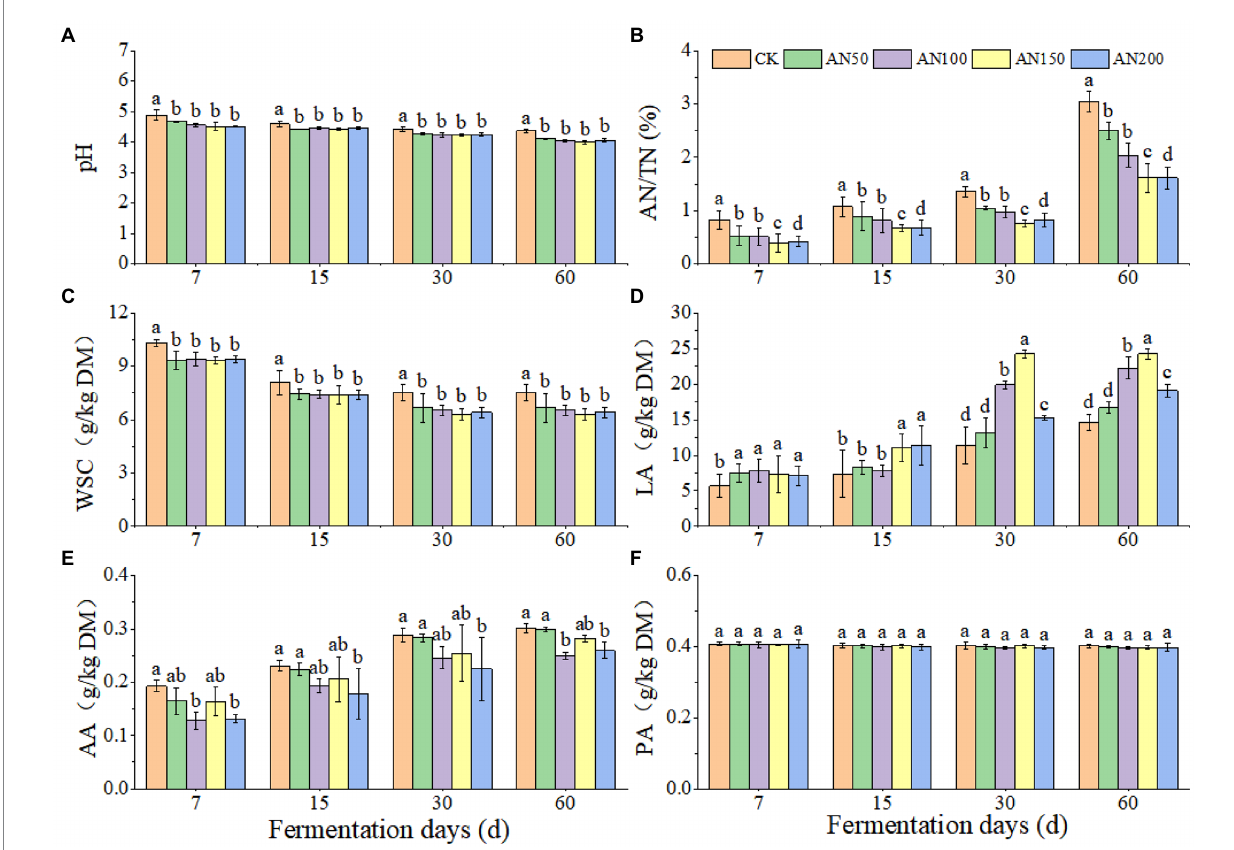
FIGURE 5 Silage quality of ratooning sorghum ensiled with different concentrations of A. niger . (A) , pH; (B) , ammonia nitrogen (AN); (C) , water soluble carbohydrate (WSC); (D) , lactic acid (LA); (E) , acetic acids (AA); (F) , propionic acid (PA). CK: 200 mL of sterile water per 3 kg of silage; AN50: 50 mL A. niger. + 150 mL sterile water per 3 kg of silage; AN100:100 mL A. niger. + 100 mL sterile water per 3 kg of silage; AN150: 150 mL A. niger. + 50 mL sterile water per 3 kg of silage; AN200: 200 mL A. niger. per 3 kg of silage. Different lowercase letter above the data bar represented significance between concentrations of A. niger. within same fermentation time at p < 0.05.